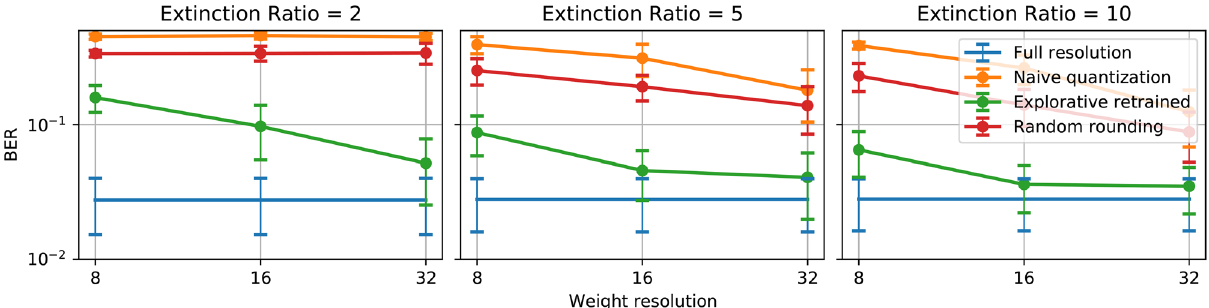
Figure 6. Performance comparison of three different extinction ratios, 2 (left), 5 (middle), 10 (right) for the 4-bit delayed XOR task over different resolutions. The blue curve represents the performance of full-resolution weights; the orange curve represents ‘naive’ quantization weights; the green curve for explorative retrained quantization